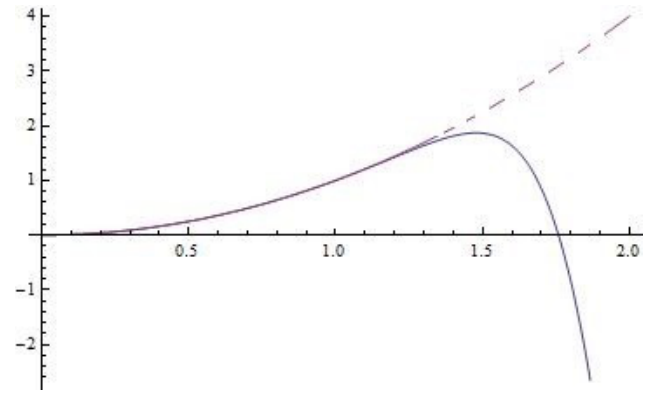
Fig. 1 A comparison graph between AIM and exact